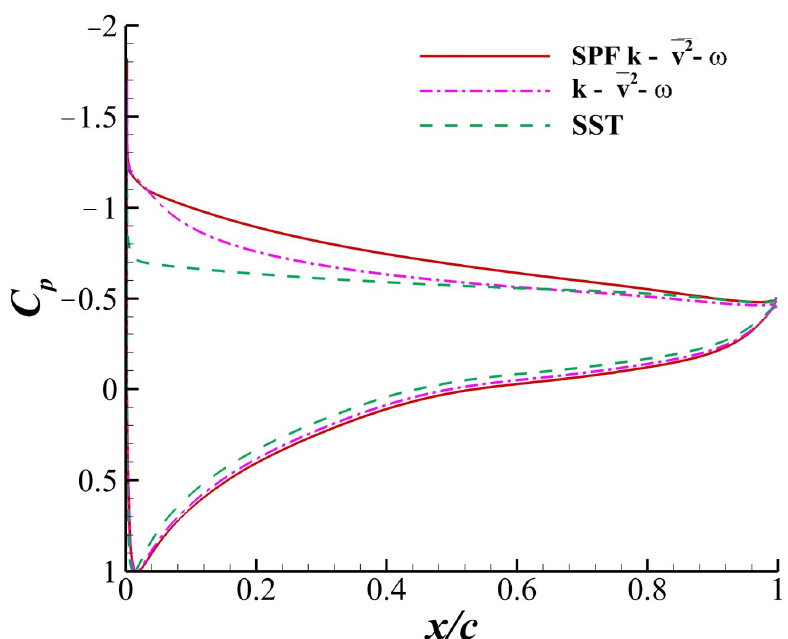
Figure 6. 𝐶 distributions on the surface of the airfoil obtained by the SST, 𝑘 − 𝑣 (cid:2870) (cid:3364)(cid:3364)(cid:3364) − 𝜔 and SPF Figure 6. C p distributions on the surface of the airfoil obtained by the SST, k − v 2 − ω and SPF models. (cid:3043) models. 𝐴𝑂𝐴 = 17°, 𝑅𝑒 = 3 × 10 (cid:2873) and 𝑀𝑎 = 0.12 . AOA = 17 ◦ , Re = 3 × 10 5 and Ma =